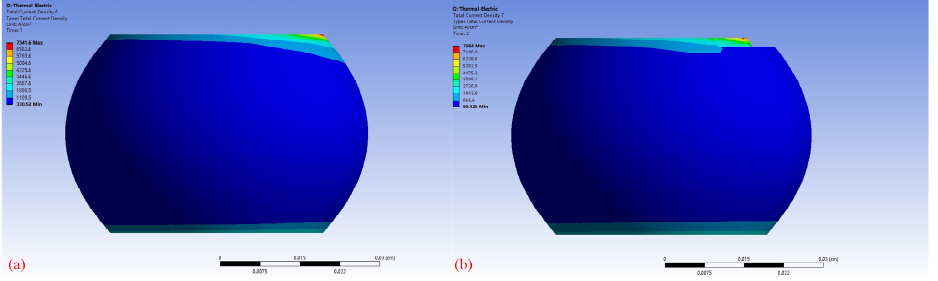
Figure 7. Simulation results of the current density distribution ( a ) The initial condition ( b ) The void volume reaches 5%.